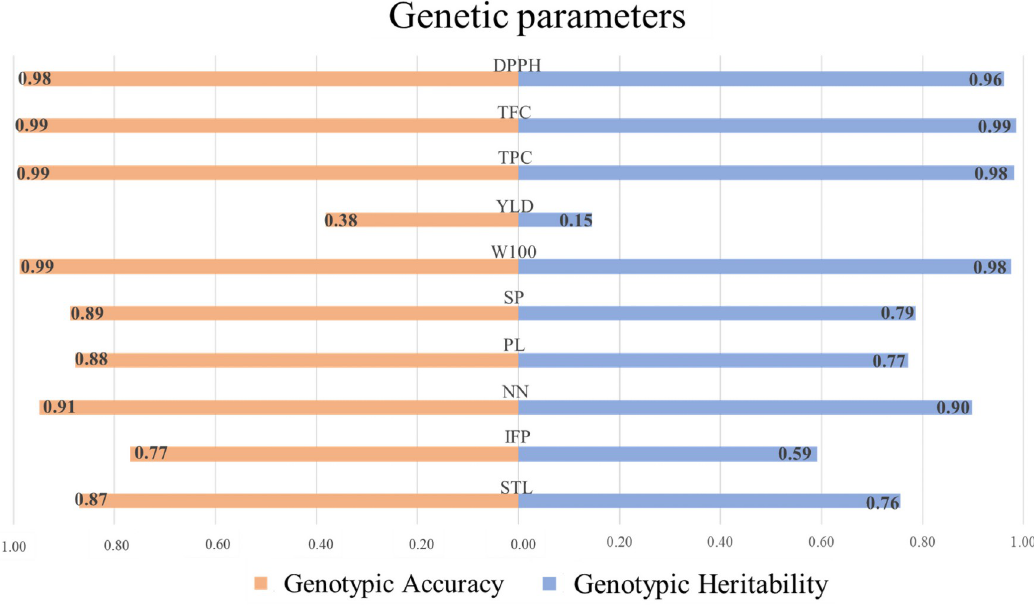
Fig 1. Broad-sense heritability and selective accuracy for morpho-agronomic and biochemical traits in 215 Mesoamerican common bean accessions. STL: Main stem length, IFP: Insertion height of the first pod, NN: Number of nodes on main stem, PL: Pod length, SP: Number of seeds per pod, W100: Weight of 100 seeds, YLD: Seed yield, TPC: Total phenolic contents, TFC: Total flavonoid contents, and DPPH: antioxidant capacity.